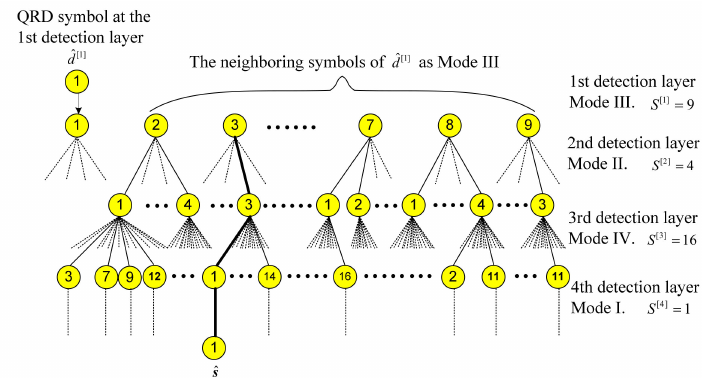
Figure 7. Example of the proposed QRD -M algorithm with N = L = 4 and 16 QAM.